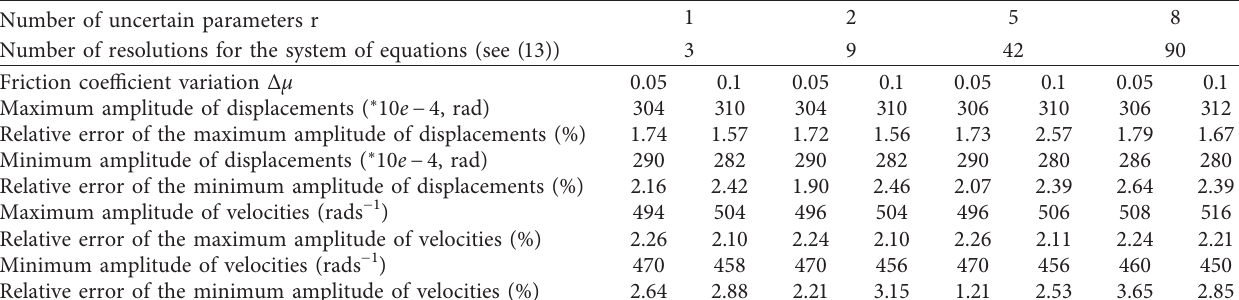
Table 5: Comparison of the limit cycles of a clutch system with 6 DOF with different intervals of the friction coefficient ( μ � 0.5; Δ V m,i � 0 .